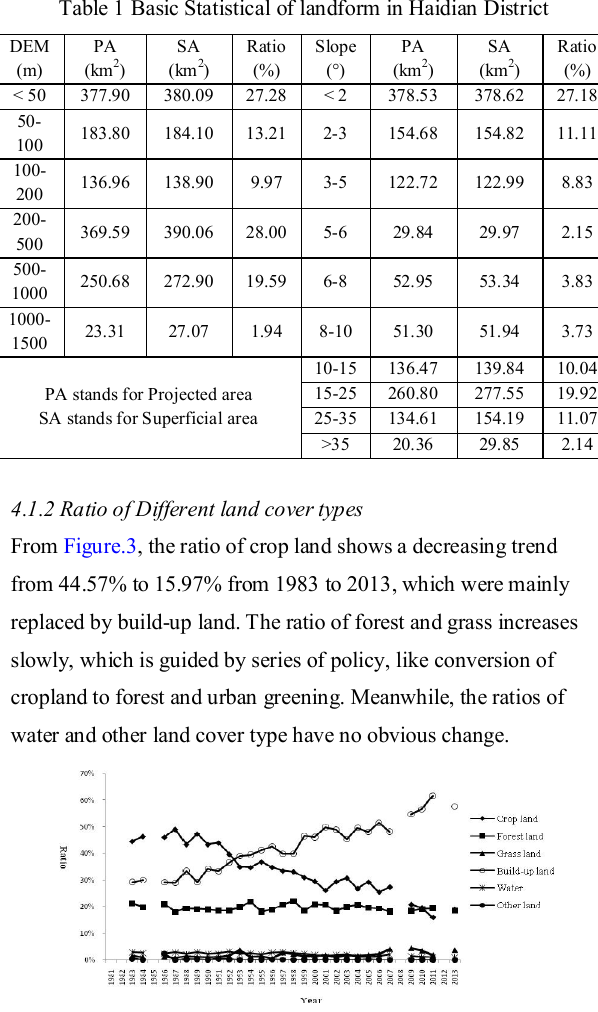
Figure.3 Temporal variation of different land cover ratio by Landsat TM between 1983 and 2013, Haidian